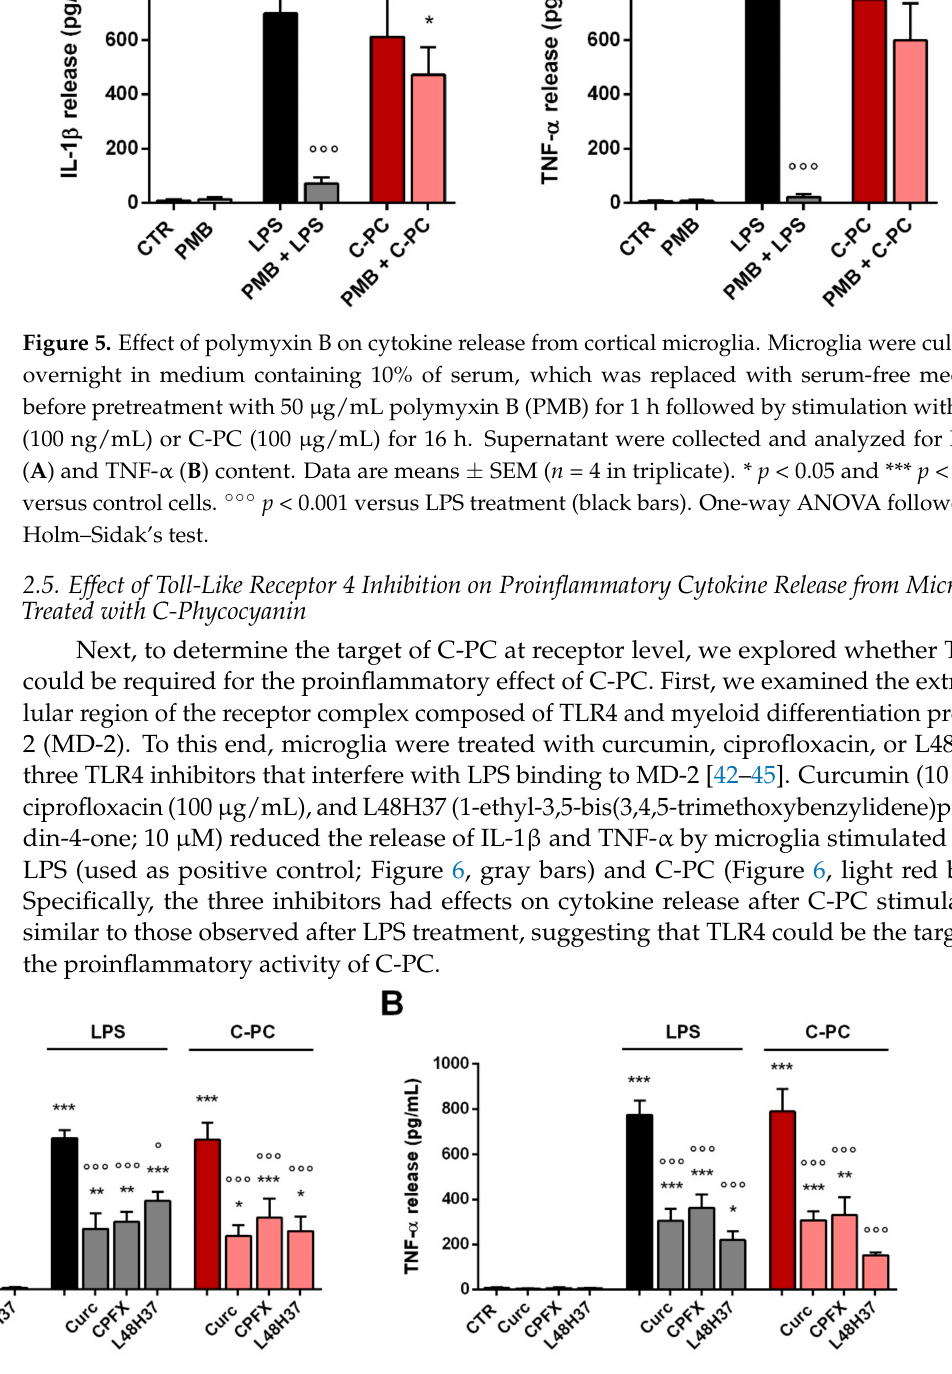
Figure 6. Effect of Toll-like receptor 4 inhibition on cytokine release from cortical microglia. Microglia were cultured overnight in medium containing 10% of serum, which was replaced with serum-free medium before pretreatment with curcumin (Curc, 10 µ M), ciprofloxacin (CPFX, 100 µ g/mL), or L48H37 (10 µ M) for 1 h followed by stimulation with LPS (100 ng/mL) or C-PC (100 µ g/mL) for 16 h. Supernatant were collected and analyzed for IL-1 β ( A ) and TNF- α ( B ) content. Data are means ± SEM ( n = 3 in triplicate). * p < 0.05, ** p < 0.01, and *** p < 0.001 versus control cells. ◦ p < 0.05 and ◦◦◦ p < 0.001 versus LPS or C-PC treatment. One-way ANOVA followed by Holm–Sidak’s